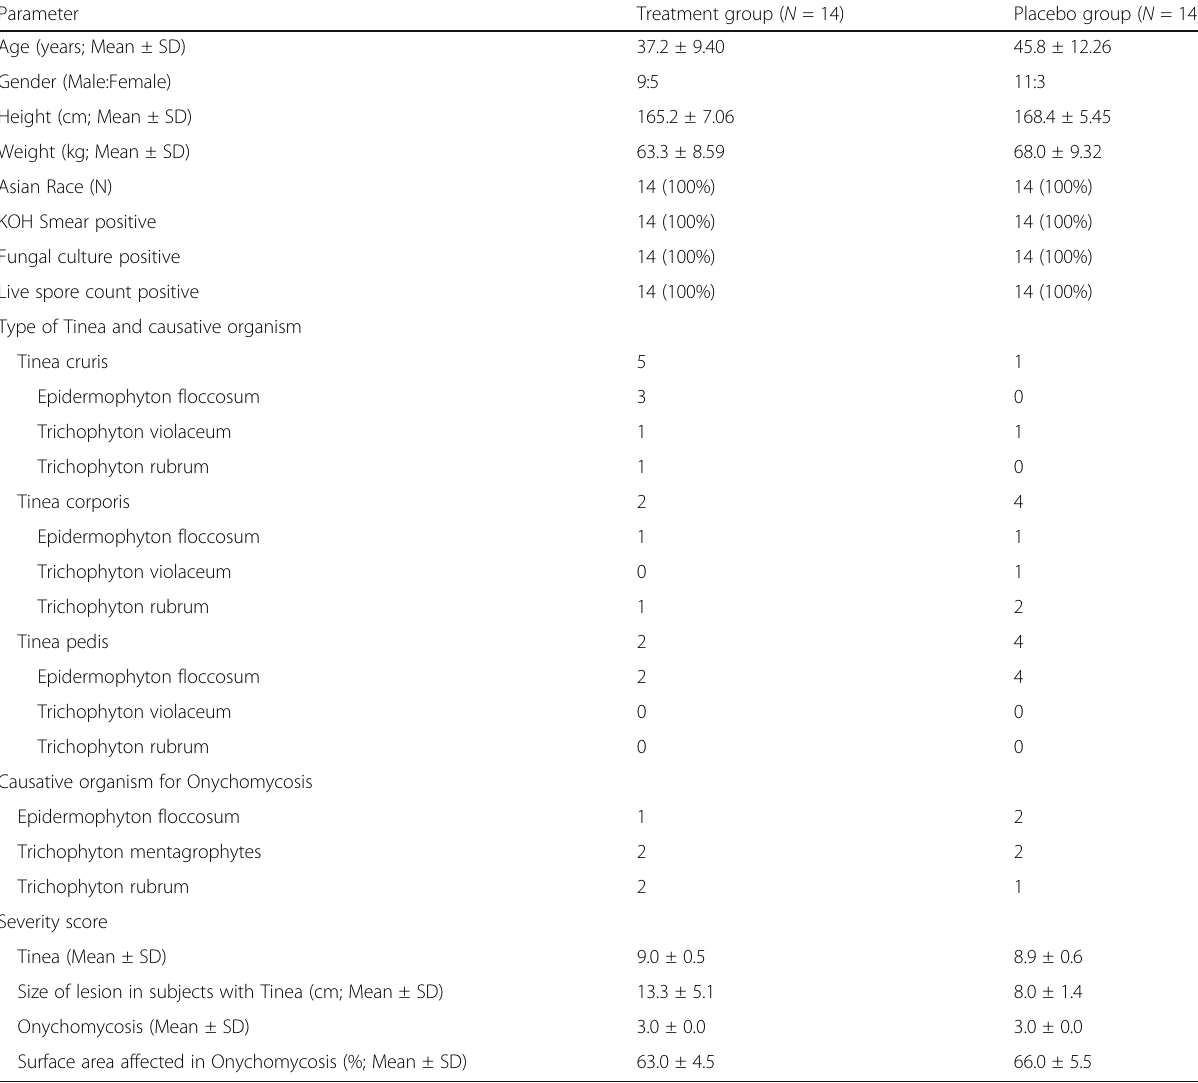
Table 2 Baseline